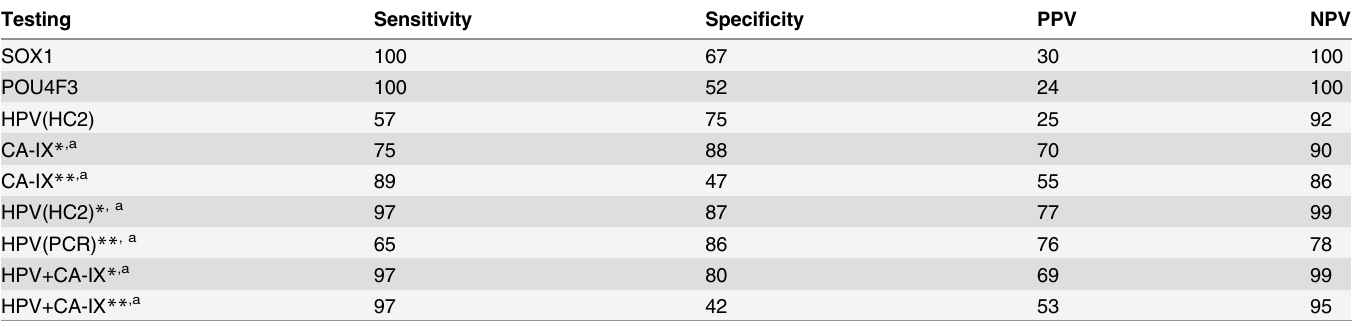
Table 3. Summary of clinical performance of methylation biomarker, HPV and